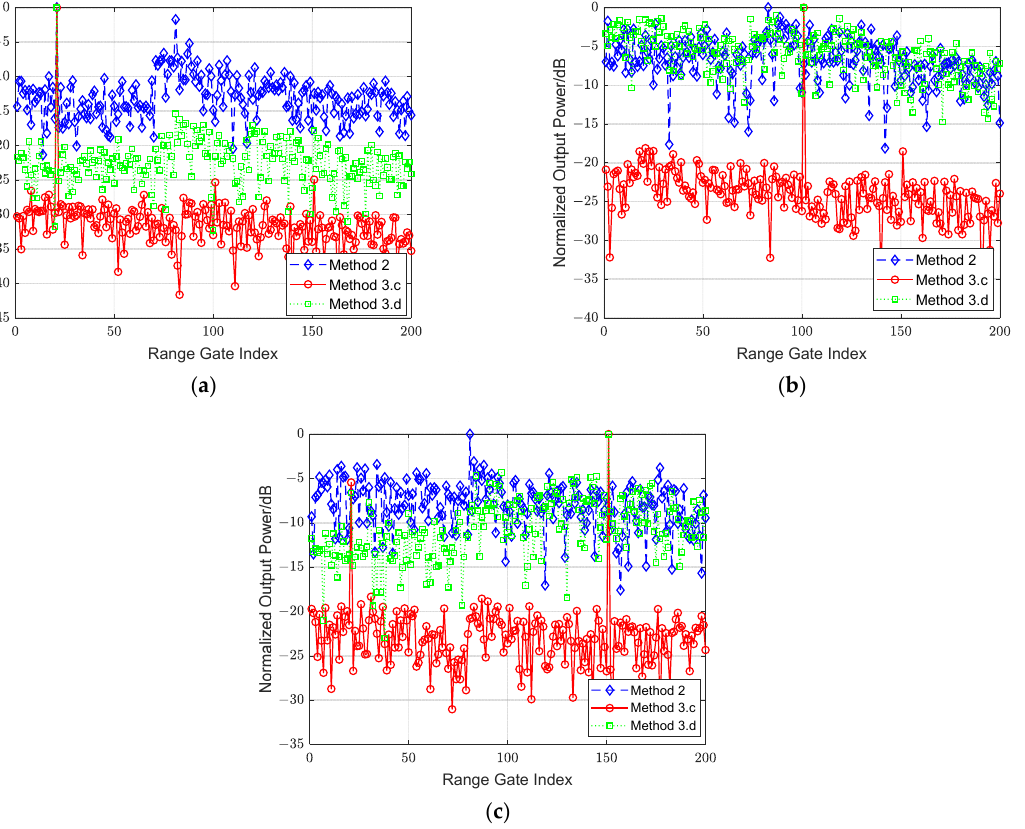
Figure 15. Normalized output power spectrum in different Doppler channels by different method 2, 3.c and 3.d: ( a ) Doppler channel of 1st target; ( b ) Doppler channel of 2nd target; ( c ) Doppler channel of 3rd target.